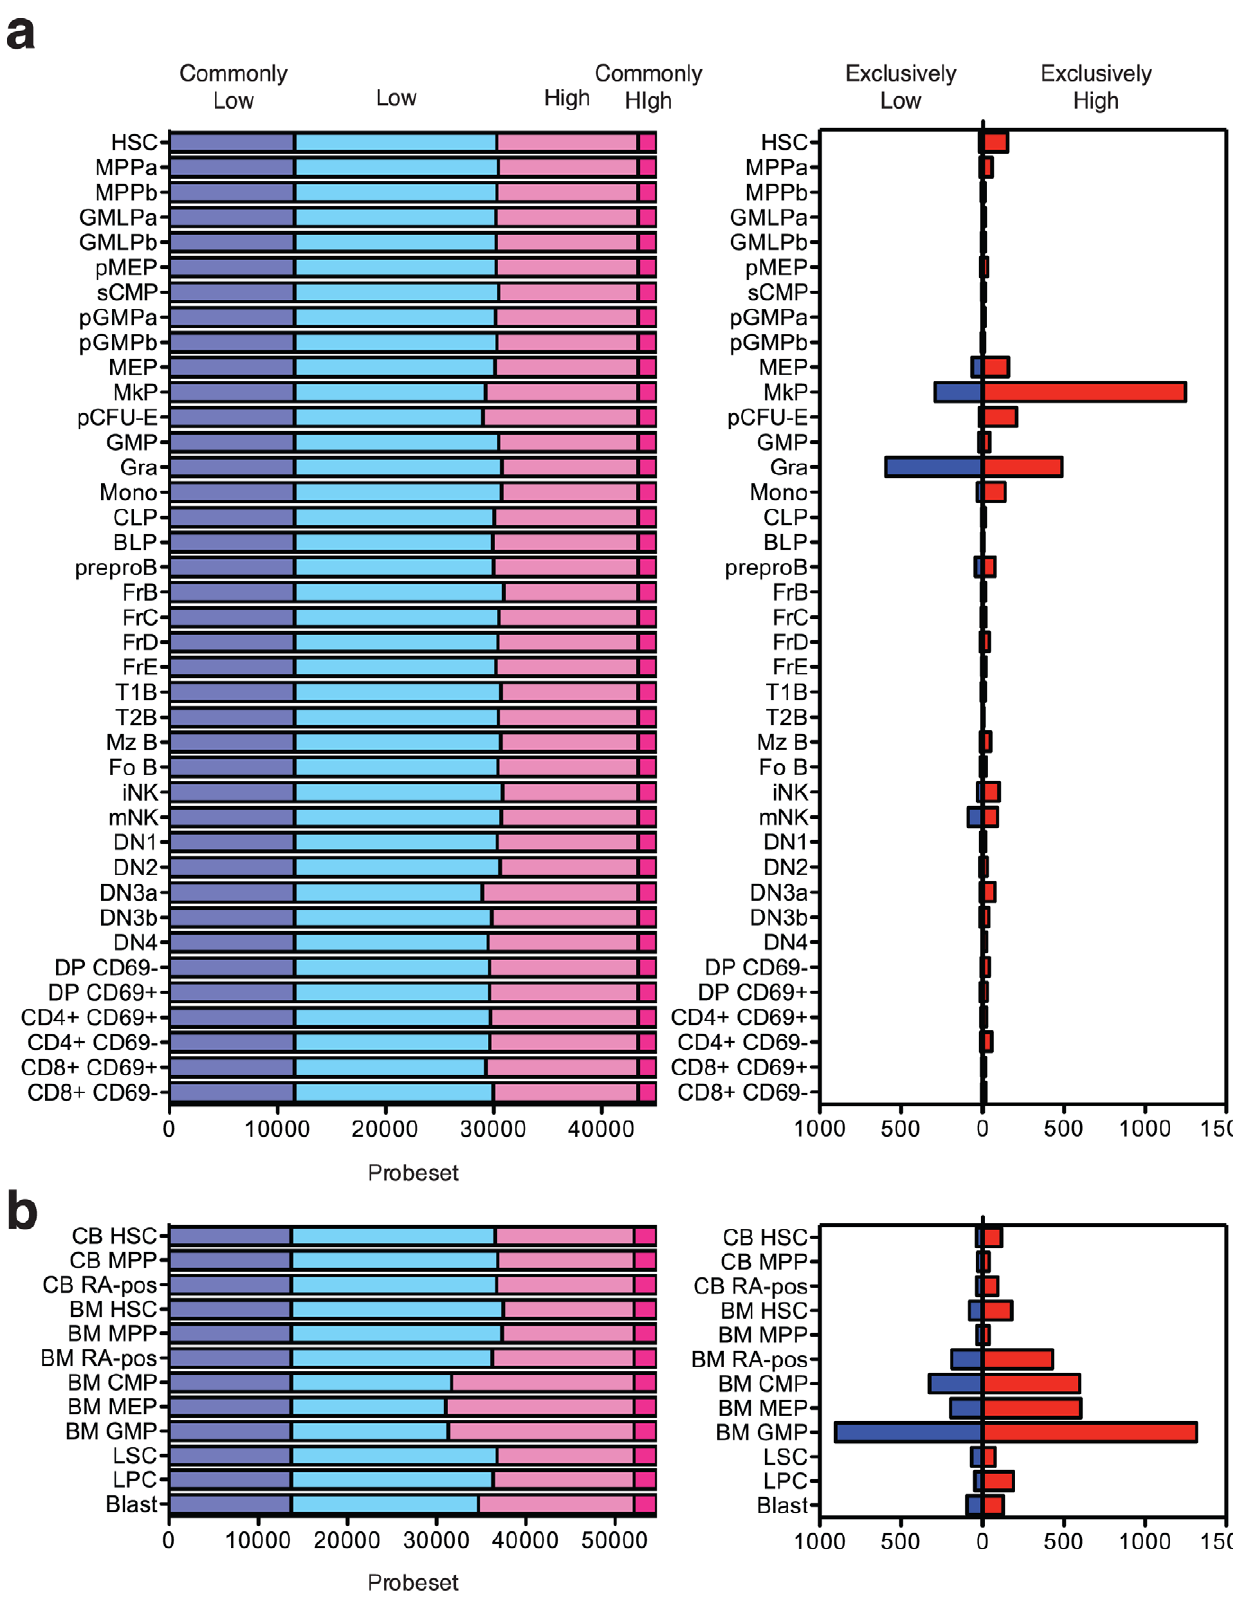
Figure 3. Gene expression pattern profiling of mouse and human hematopoiesis. Number of genes expressed at very low levels (dark blue), low levels (light blue), high levels (light red) and very high levels (dark red) in either the Mouse Hematopoiesis Model (A, left) or Human Hematooiesis Model (B, left). Number of genes expressed at high (red) and low (blue) levels in a specific population in Mouse Hematopoiesis Model